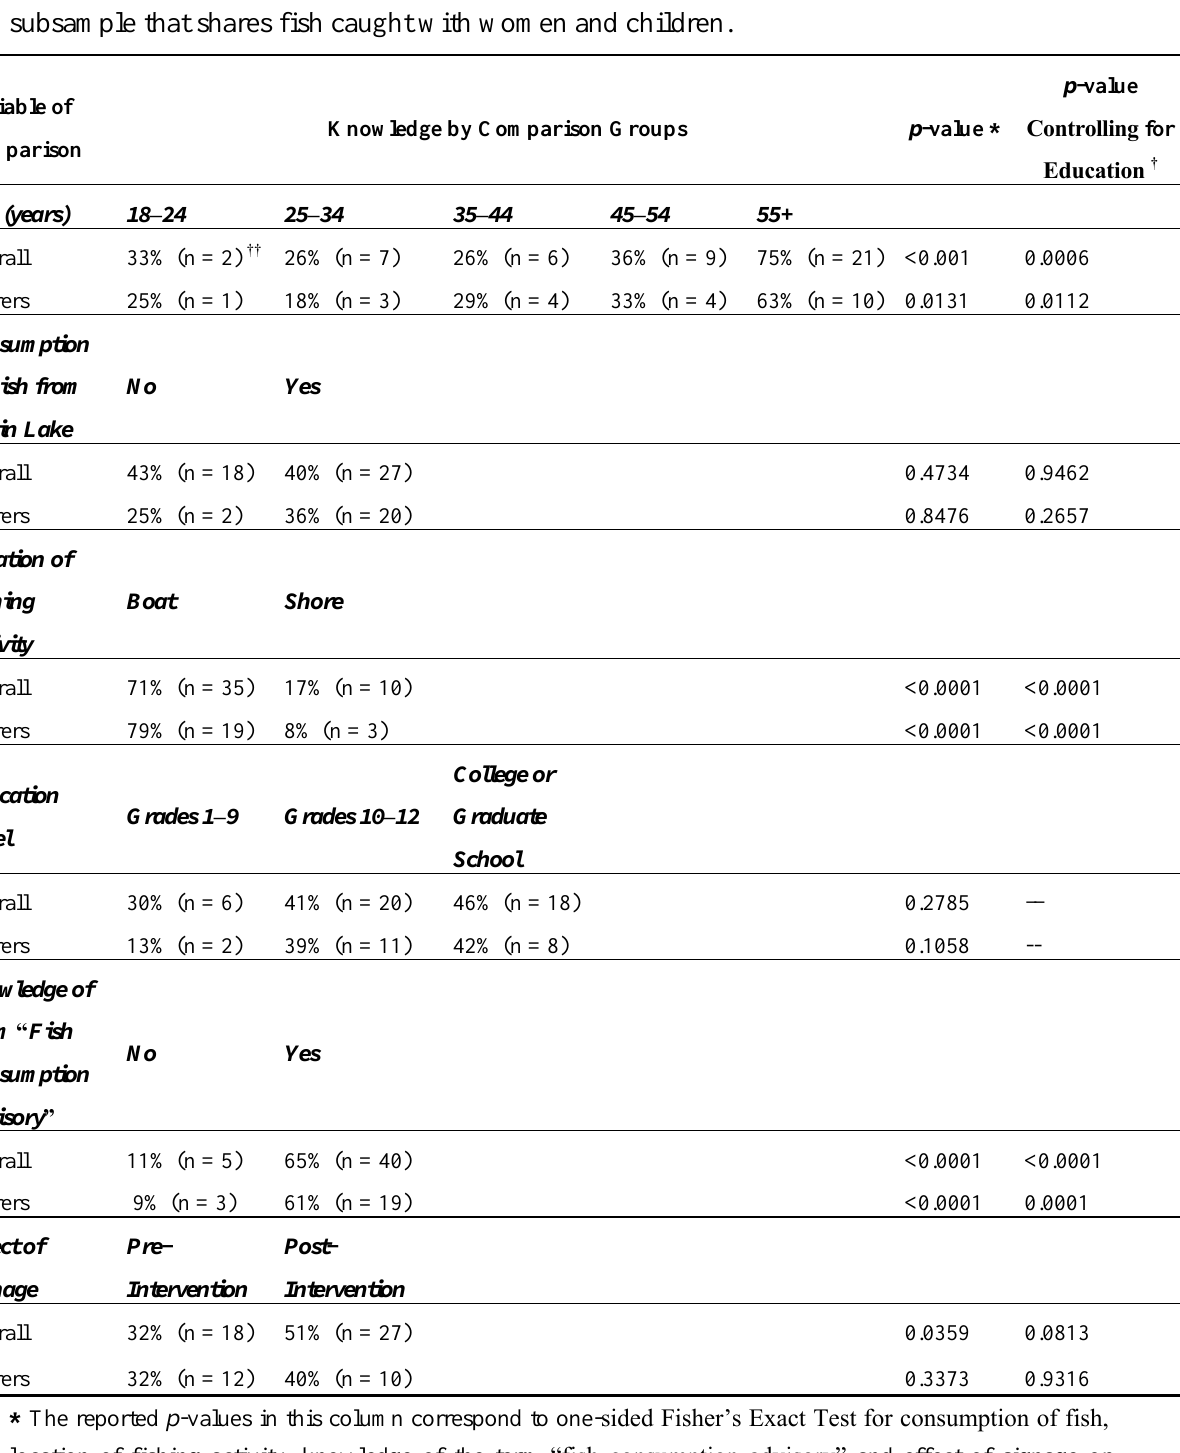
Table 3. Group differences in knowledge of the fish consumption advisory for Badin Lake for the overall sample of study participants at Badin Lake, NC, USA compared to a subsample that shares fish caught with women and